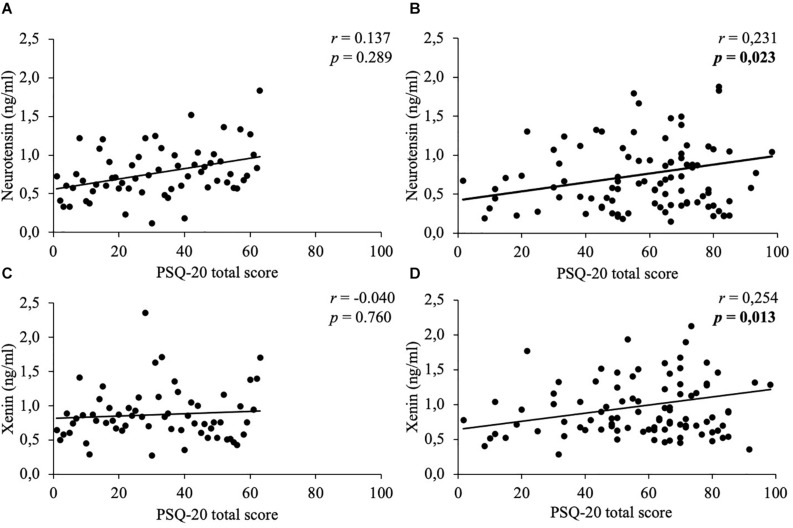
Correlations between neurotensin and xenin with PSQ-20 total scores in men and women. Overall, in women neurotensin (B) and xenin (D) showed a positive correlation with PSQ-20 total score. However, for men no significant correlations with PSQ-20 total score were detected, neither for neurotensin (A) nor for xenin (C). Correlations were calculated using Pearson’s analysis. PSQ-20, Perceived Stress Questionnaire-20.